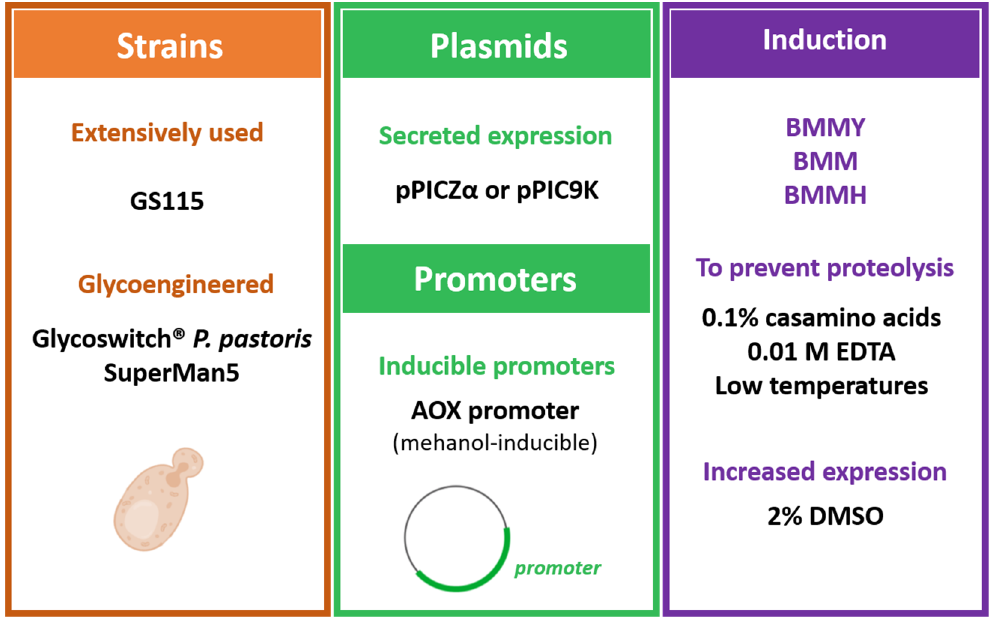
Figure 4. Optimized factors towards enhanced expression of IFNs using recombinant P. pastoris .